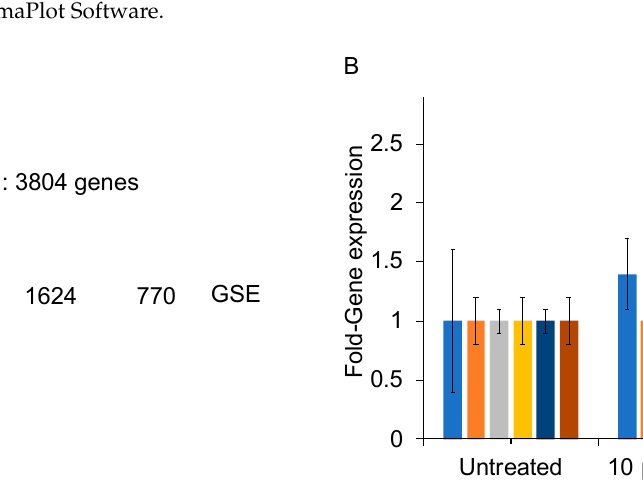
Figure 2. Gene microarray analysis of AGSE versus commercial GSE. ( A ) Gene differential expression was quantified using Clariom™ S assay microarray system method after 24 h incubation in 3D skin model EpiDerm-FT™. AGSE regulated 1410 unique genes compared to commercial GSE. Novel pathways modulated by AGSE were collagen biosynthesis via upregulating collagen types I, III and IV. ( B ) Primary Normal Human Dermal Fibroblasts (NHDFs) were cultured in the presence of each extract for 24 h. Total RNA was collected after 24 h and analyzed by qPCR. GSE and AGSE were tested at 10 µ g/mL. Data represents mean ± SE from three independent experiments. * p < 0.05; ** p ≤ 0.01 relative to vehicle-only treated cells.